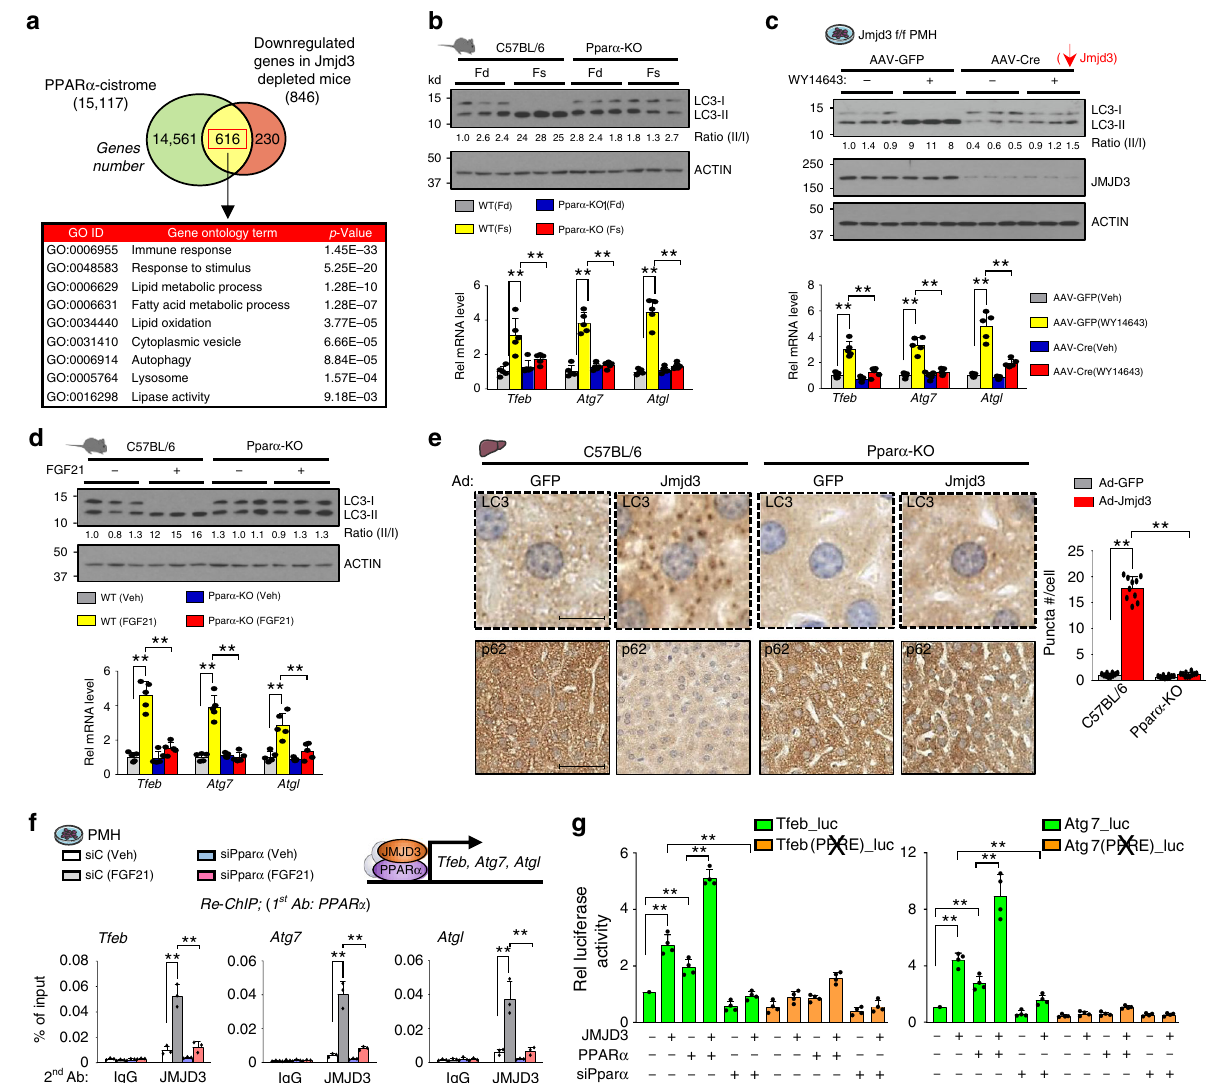
Fig. 5 JMJD3 coactivates PPAR α to induce hepatic autophagy. a Venn diagram (top) for genes with PPAR α cistrome detected by ChIP-seq and hepatic genes inhibited by liver JMJD3 downregulation (as shown in Fig. 1b). G/O analysis (bottom) of the overlapping genes. b WT or PPAR α -KO mice were fasted (Fs) for 24 h or refed for 24 h (Fd) after fasting. Levels of LC3 in liver extracts measured by IB with the LC3-II/I ratios shown below the blot (top, n = 3 mice). The mRNA levels of indicated genes (bottom, n = 5 mice). c PMH from JMJD3- fl oxed mice were infected with AAV-GFP or AAV-Cre for 72 h and treated with vehicle or WY14643 for 12 h. The indicated proteins were detected by IB with the LC3-II/I ratios shown below the blot (top, n = 3 culture dishes). The mRNA levels of indicated genes (bottom, n = 5 mice). d C57BL/6 or PPAR α -KO mice were fasted for 1 h and treated with vehicle or 0.1 mg/kg FGF21 for 3 h. Hepatic levels of LC3 measured by IB with the LC3-II/I ratios shown below the blot (top, n = 3). The mRNA levels of indicated genes (bottom, n = 5 mice). e LC3 and p62 detected by IHC. Representative images of liver sections (left) and the average number of puncta/cell (right, n = 10 hepatocytes) are shown (scale bar = 10 μ m for LC3, 50 μ m for p62). f re-ChIP: Hepatocytes were transfected with PPAR α siRNA, 72 h later, cells were treated with FGF21 for 2 h. PPAR α was immunoprecipitated followed by immunoprecipitation of JMJD3, and enrichment of Tfeb , Atg7, and Atgl sequences was determined ( n = 3 culture dishes). g Hepa1c1c7 cells were transfected with a luciferase reporter containing the PPAR α binding site or mutated site from Tfeb or Atg7 and with plasmids and siRNAs as indicated. After 36 h, the cells were treated with 50 μ M WY14643 and 100 ng/ml FGF21 overnight. Luciferase activities were normalized to β -galactosidase activities ( n = 4 culture dishes). Source data are provided as a Source Data fi le. b – g Values are presented as mean ± SD. Statistical signi fi cance was measured using the g one- or b – f two-way ANOVA with the Bonferroni post-test. ** P <